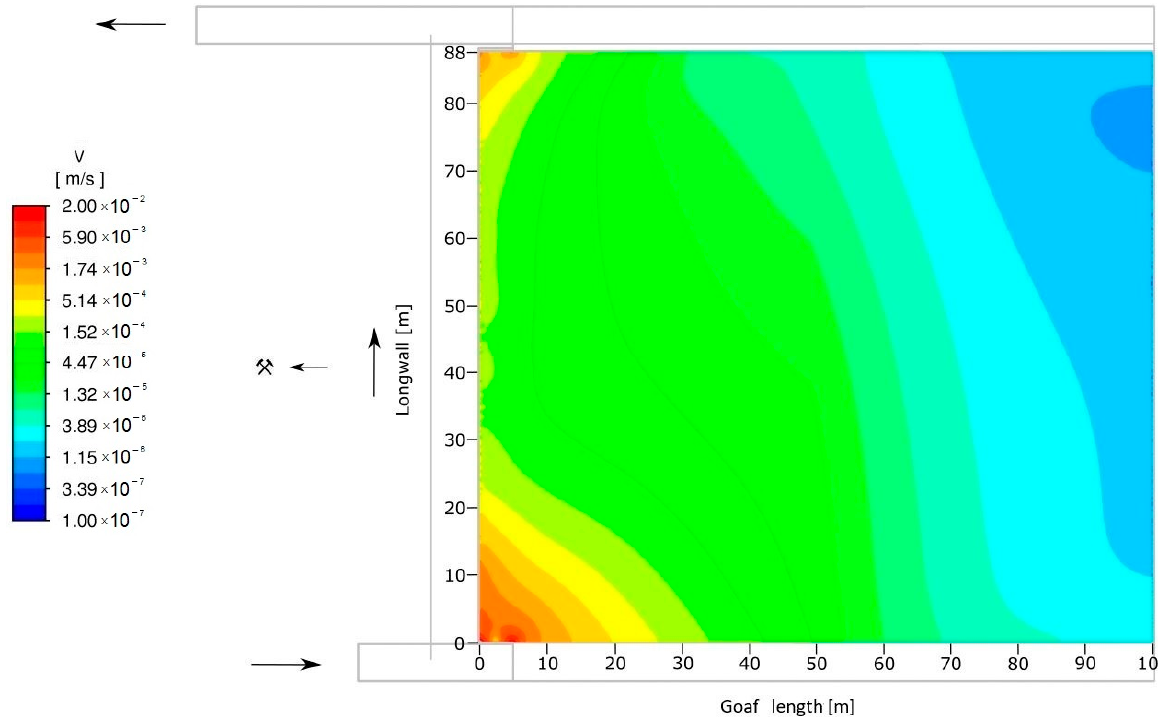
Figure 8. Velocity contours on a logarithmic scale in the range from 1.0 × 10 − 7 m/s to 0.02 m/s for a model with variable parameters of porosity and permeability in the goaf.